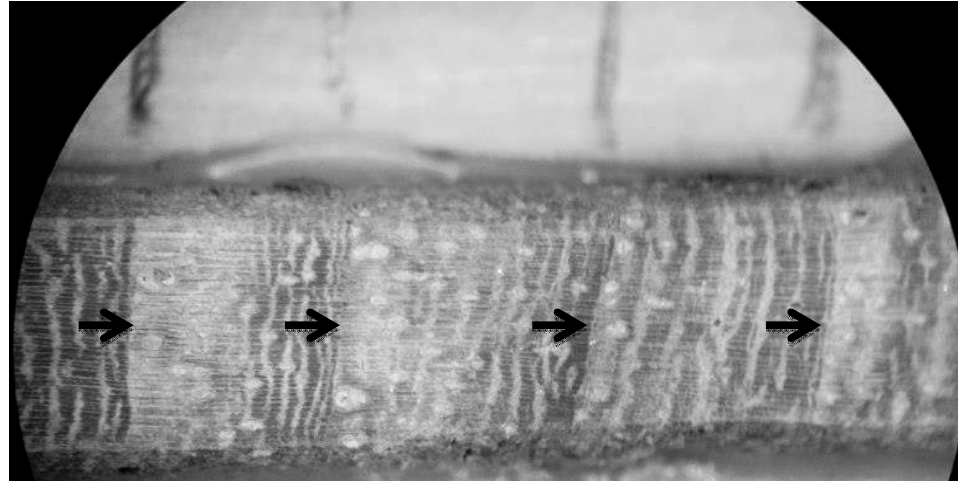
Figure 3. Ring structure of Pterocarpus angolensis (stereo-zoom microscope). Arrows illustrate the clarity of the tree rings and direction of growth.